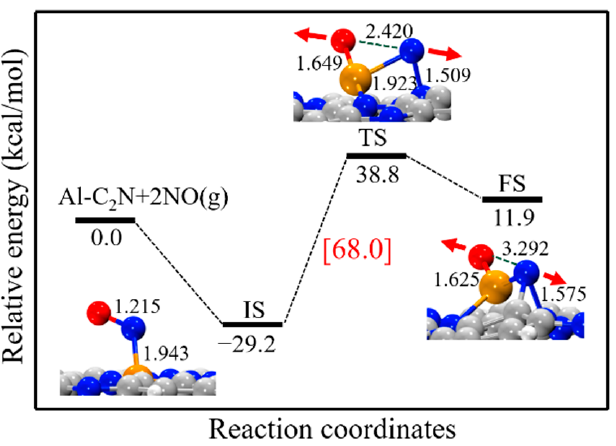
Figure 3. The energy profile and corresponding structure for the NO direct decomposition process on Al-C 2 N. All bond lengths are in Å.